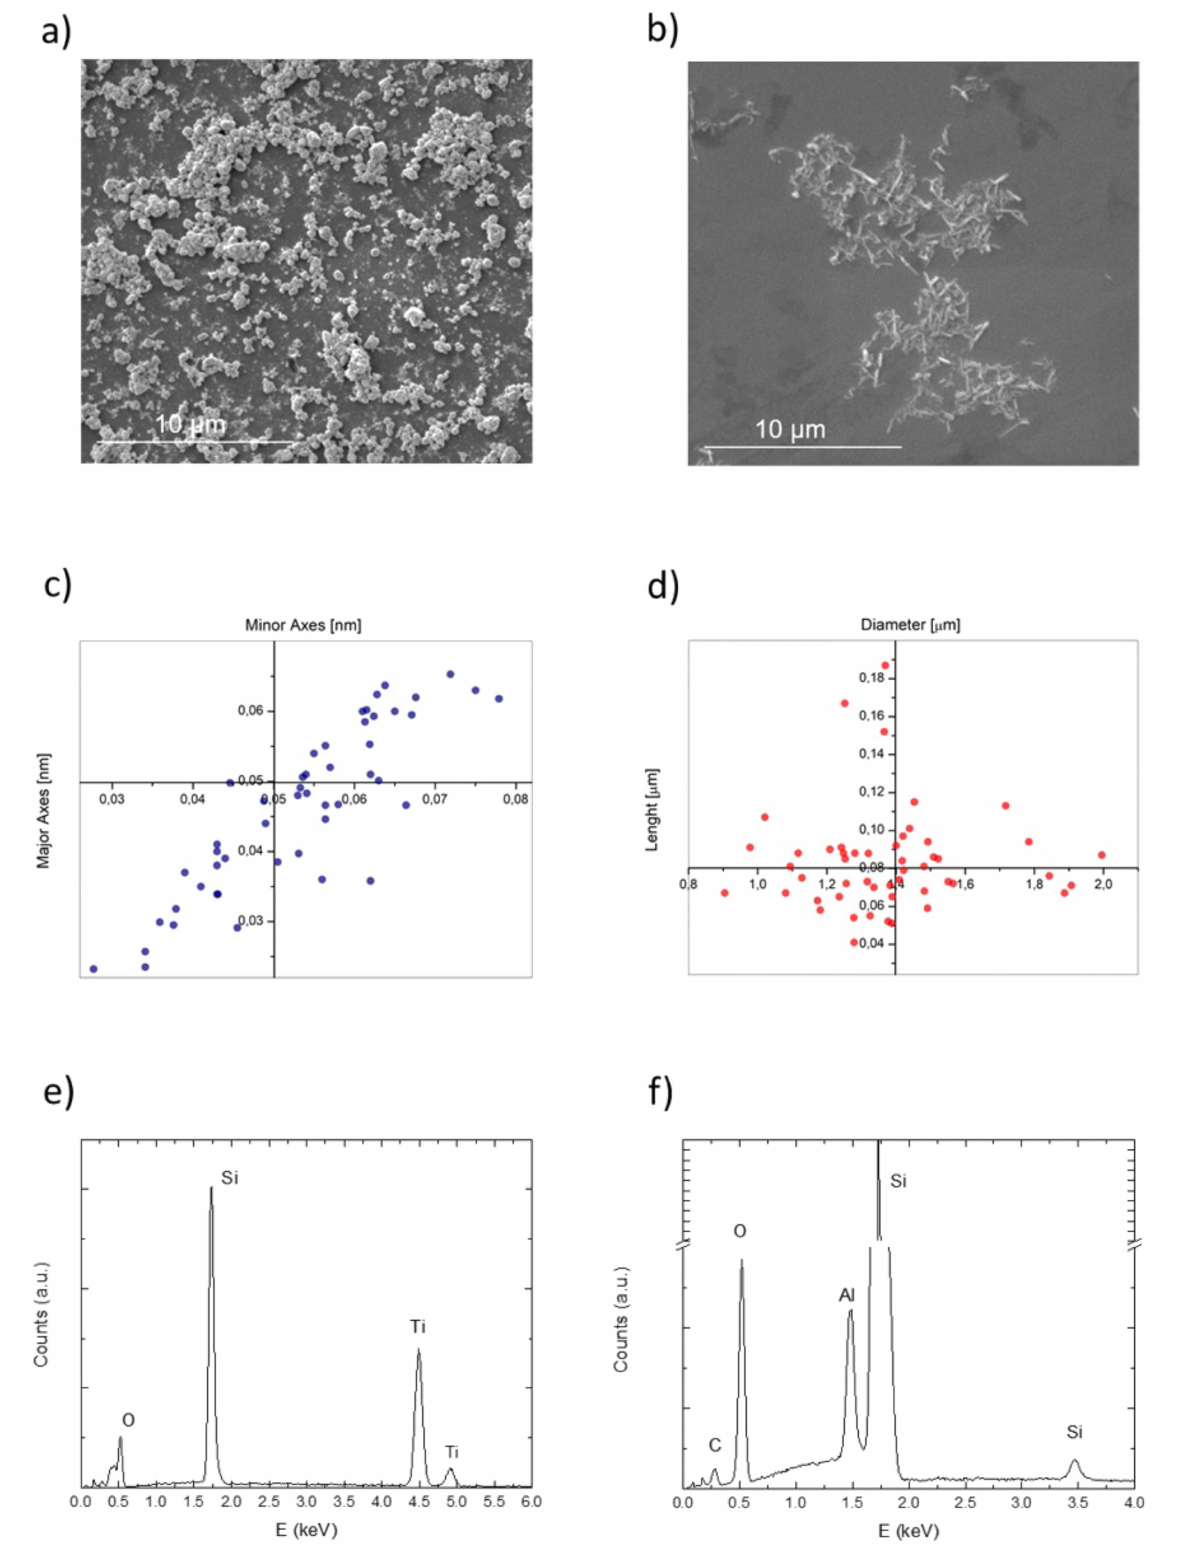
Figure 1. Representative SEM acquisitions of TiO 2 NPs ( a ) and HNTs ( b ) on monocrystalline silicon wafer at the accelerating voltage of 5 kV. Size distribution of TiO 2 NPs ( c ), in terms of major and minor axes length, and HNTs size distribution ( d ), in terms of diameter and lenght dimensions. EDS characterization (accelerating voltage 20 kV) of TiO 2 NPs ( e ) and HNTs ( f